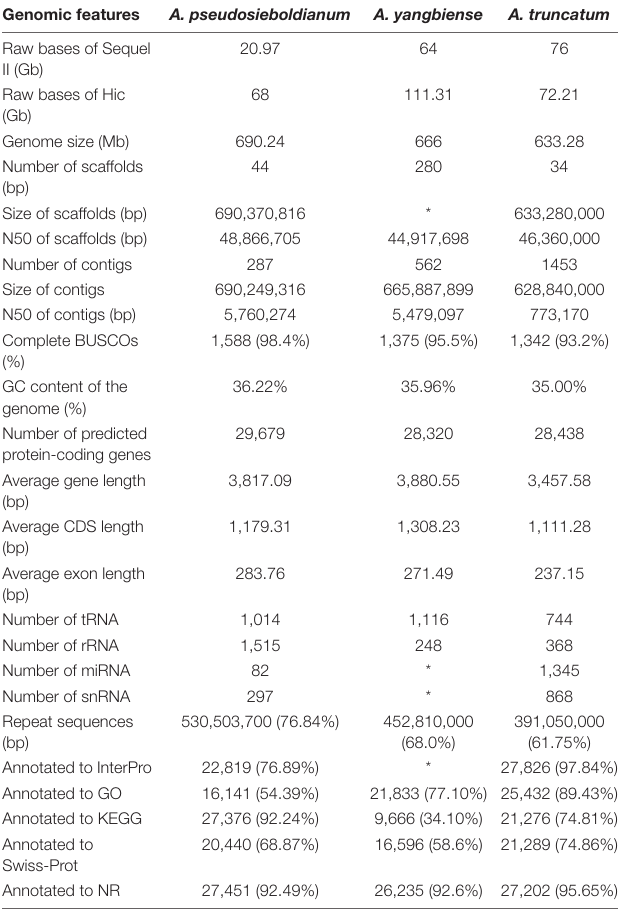
TABLE 1 | Summary of the genome assembly and annotation in Acer